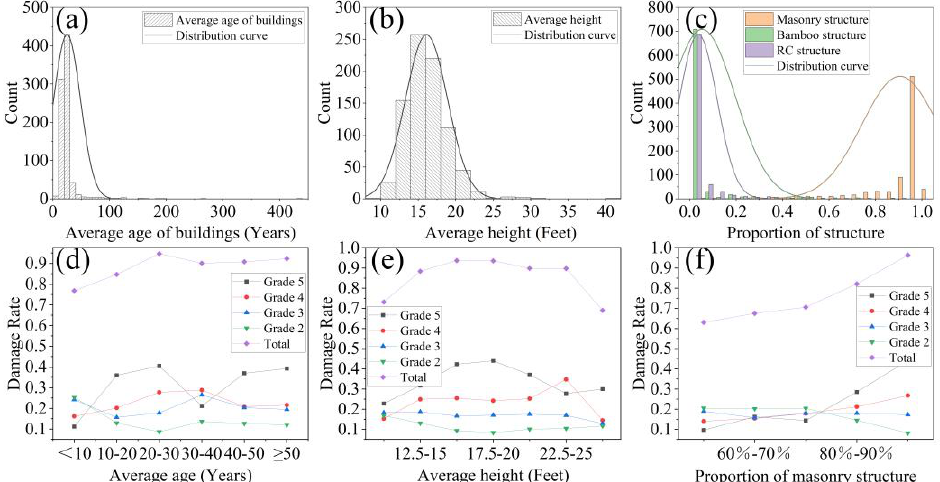
Figure 7. Damage rate curves of different damage levels and distribution of building attributes. Subplot ( a ), the building age distribution; subplot ( d ), the damage rate curves of different age; subplot ( b ), the building height distribution; subplot ( e ), the damage rate curves of different height; subplot ( c ), the distribution of different building structures; subplot ( f ) shows the effect of different stone masonry proportions on the damage rate.